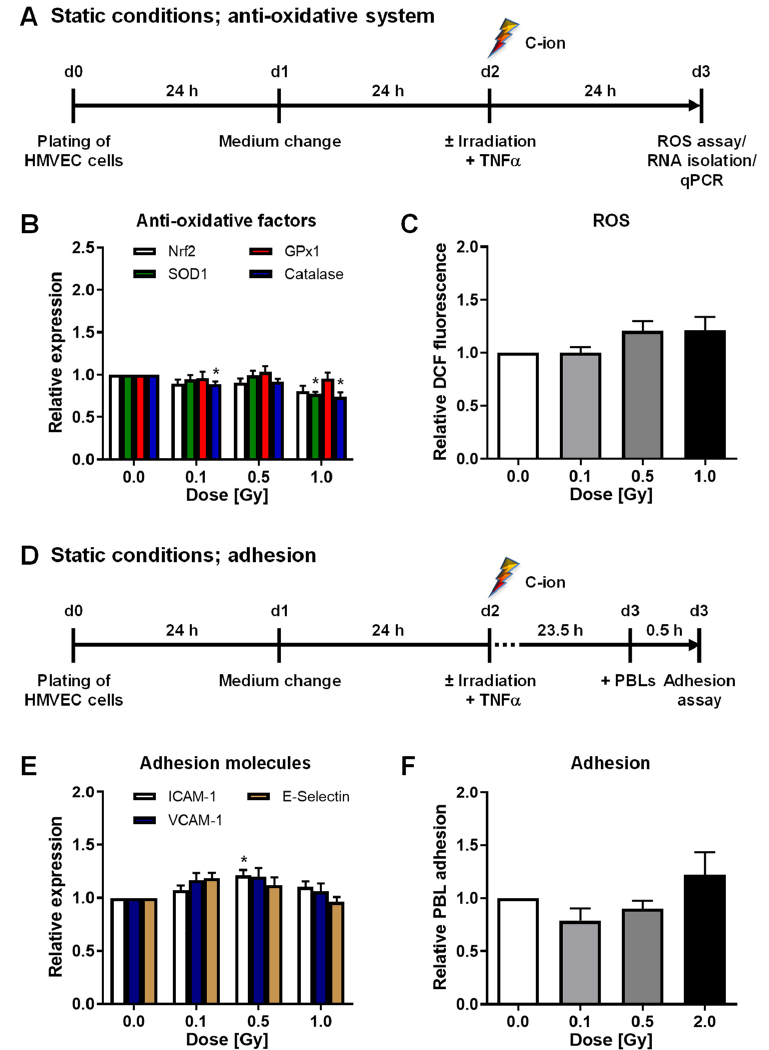
Figure 5. C-ion irradiation moderately changes the mRNA expression of anti-oxidative factors, ROS and adhesion of HMVEC cells under static conditions. ( A ) Experimental time course of analysis of C-ion irradiation-induced changes of the anti-oxidative defense of HMVEC, cultured under normal static conditions. ( B ) Relative mRNA expression of Nrf2, SOD1, GPx1 and Catalase at 24 h after C-ion irradiation (mean + SEM; n = 8; * p < 0.05, Kruskal-Wallis test vs. 0 Gy). ( C ) Intracellular ROS content, relative to non-irradiated cells, after C-ion irradiation of HMVEC with indicated doses (mean + SEM; n = 7–8). ( D ) Experimental setup of adhesion assays, performed 24 h after C-ion exposure. ( E ) Relative mRNA expression of indicated adhesion molecules after irradiation with C-ions (mean + SEM; n = 8; * p < 0.05, Kruskal-Wallis test vs. 0 Gy). ( F ) Relative PBL adhesion at 24 h after irradiation of HMVEC cells with C-ions (mean + SEM; n =